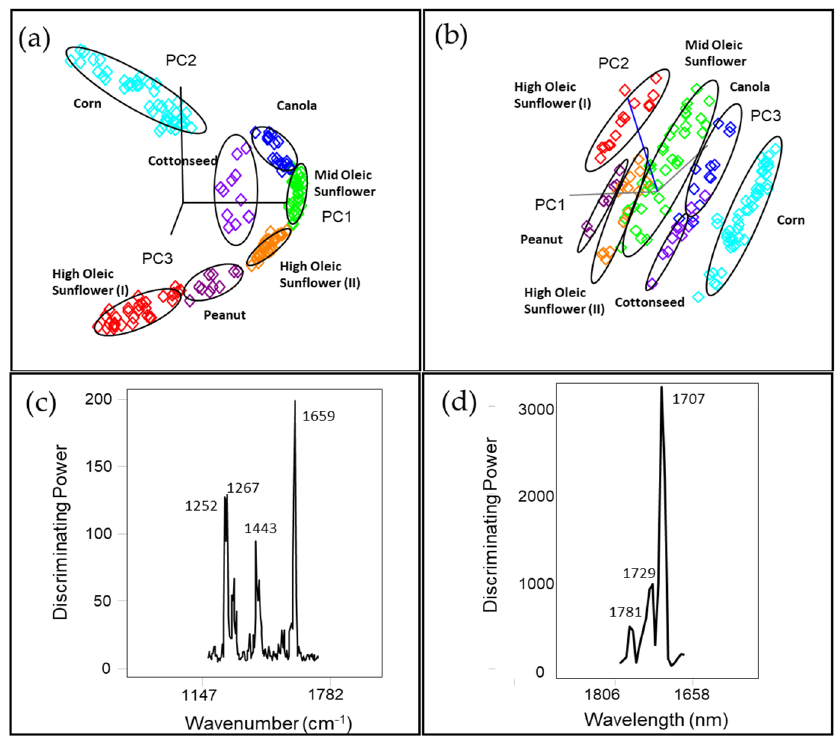
Figure 3. Soft Independent Model of Class Analogies (SIMCA) 3D projection plots of spectral data for potato chip oil samples collected by ( a ) a handheld Raman spectrometer (1064 nm) and ( b ) a miniature near Infrared (NIR) sensor. ( c ) Discriminating plots of Raman and ( d ) NIR SIMCA models showing bands and regions responsible for class separation. Table 2. Interclass distance between 7 types of potato chip frying oil based on the SIMCA training model generated by ( a ) the Raman spectral data collected in the 790 – 1782 cm – 1 region and ( b ) NIR spectral data collected in the 1350 – 2552 nm region.